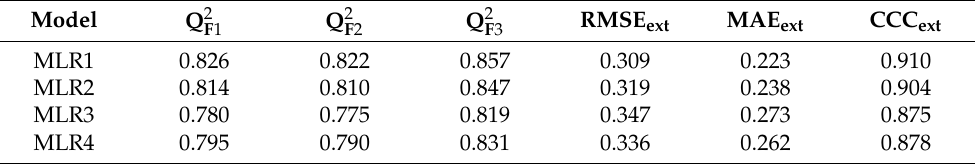
Table 3. The model predictivity results *.